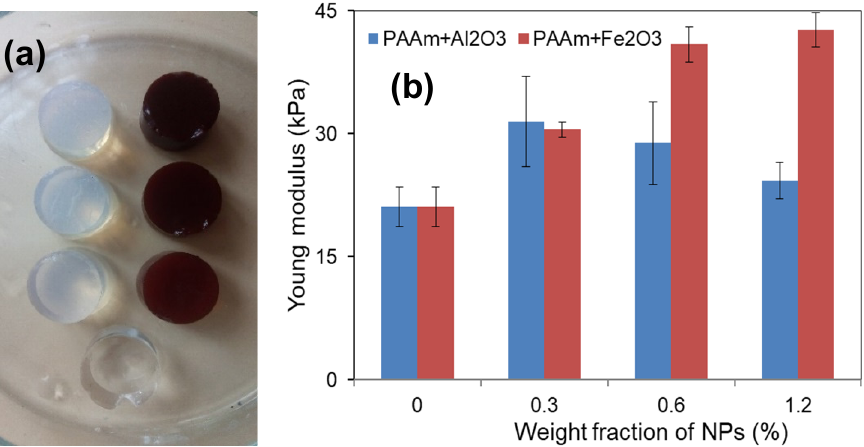
Figure 5. General view of gel-based samples: ( a ) ANPs-based composites, ( b ) MNPs-based composites, and the completely transparent sample is a blank gel; the diameter of the gel samples was equal to 13 mm. The values of Young’s modulus for PAAm hydrogels filed with different concentrations of MNPs or ANPs. Data presented as mean value and standard deviation bar ( n = 5).